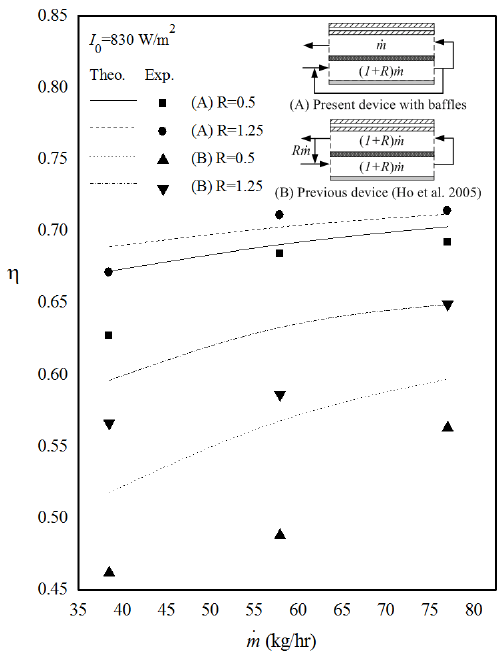
Figure 11. Comparisons of collector efficiency among the present and previous works